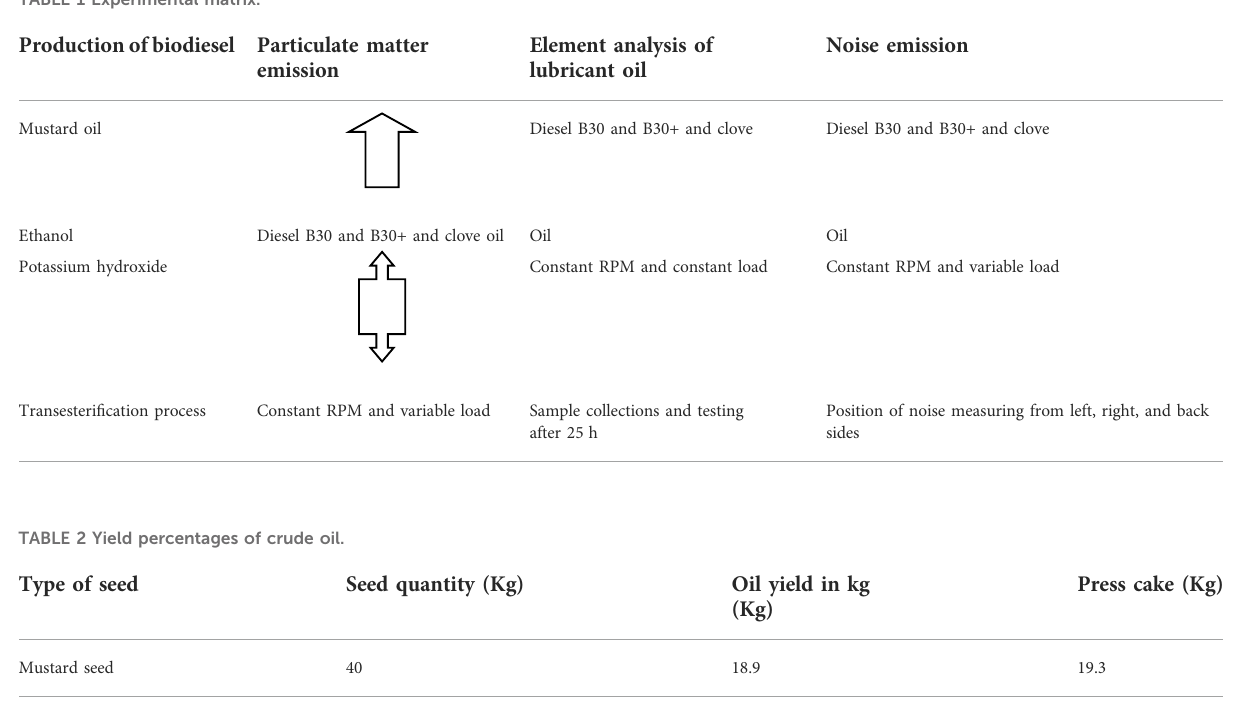
TABLE 1 Experimental matrix.